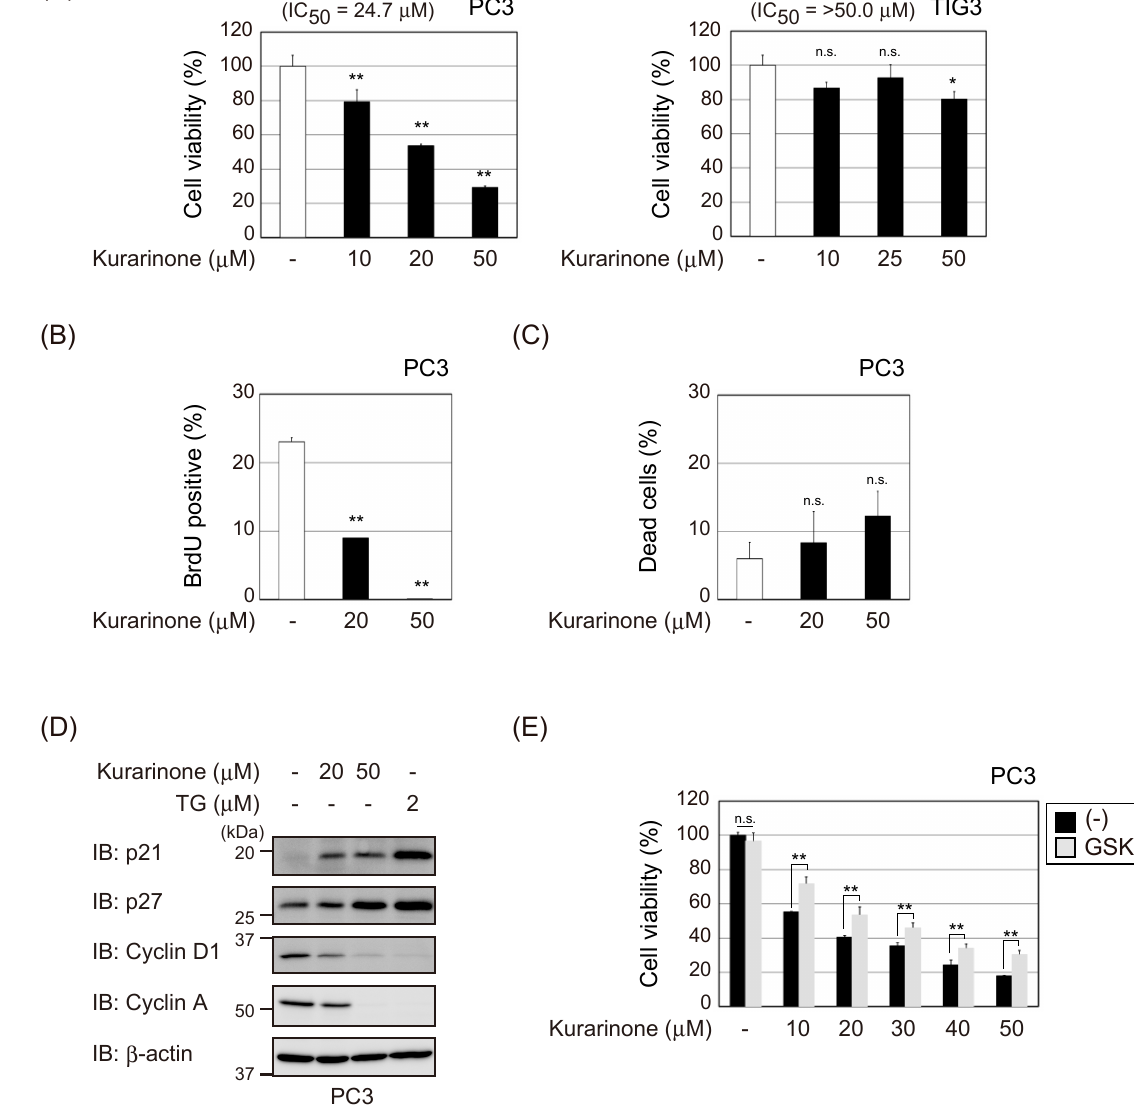
Figure 4. Kurarinone exerts cytostatic effects on cancer cells. ( A ) PC3 and TIG3 cells were incubated with the indicated doses of kurarinone for 48 h. Cell viability was determined by WST-8 assay. Results represent the mean ± S.D. ( n = 3). ( B ) PC3 cells were incubated with the indicated doses of kurarinone for 48 h. Cells were labeled with 10 μ M of BrdU for 1 h and analyzed by fluorescence-activated cell sorting. The average percentage of BrdU-positive cells is shown. Results represent the mean ± S.D. ( n = 3). ( C ) PC3 cells were exposed to the indicated doses of kurarinone for 48 h. The percentage of dead cells was measured by trypan blue staining. Results were shown as the mean ± S.D. ( n = 3). ( D ) PC3 cells were incubated with the indicated doses of TG or kurarinone for 6 h. Cell lysates were immunoblotted with the indicated antibodies. ( E ) PC3 and TIG3 cells were exposed to the indicated doses of kurarinone with or without 1 μ M of GSK2656157 (GSK) for 48 h. Cell viability was determined by WST-8 assay as in ( A ). Results represent the mean ± S.D. ( n = 3). Significant differences are indicated as ** p < 0.01. * p < 0.05. n.s.: not significant.